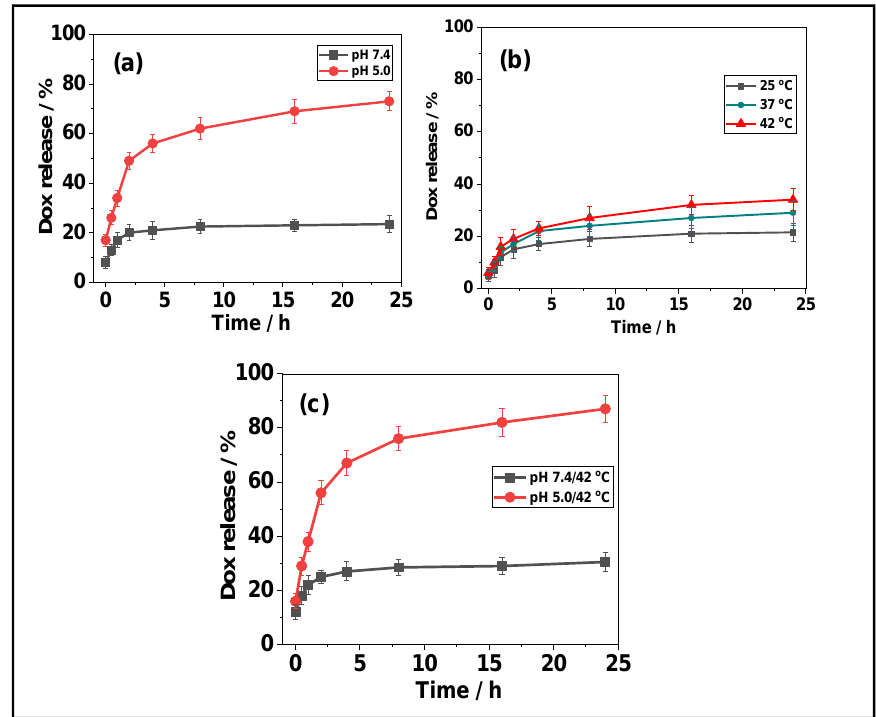
Figure 4. In vitro Dox release from the FeNP@MSHC/Dox NPs at ( a ) different pH; ( b ) different temperature; ( c ) the combined pH and temperature.